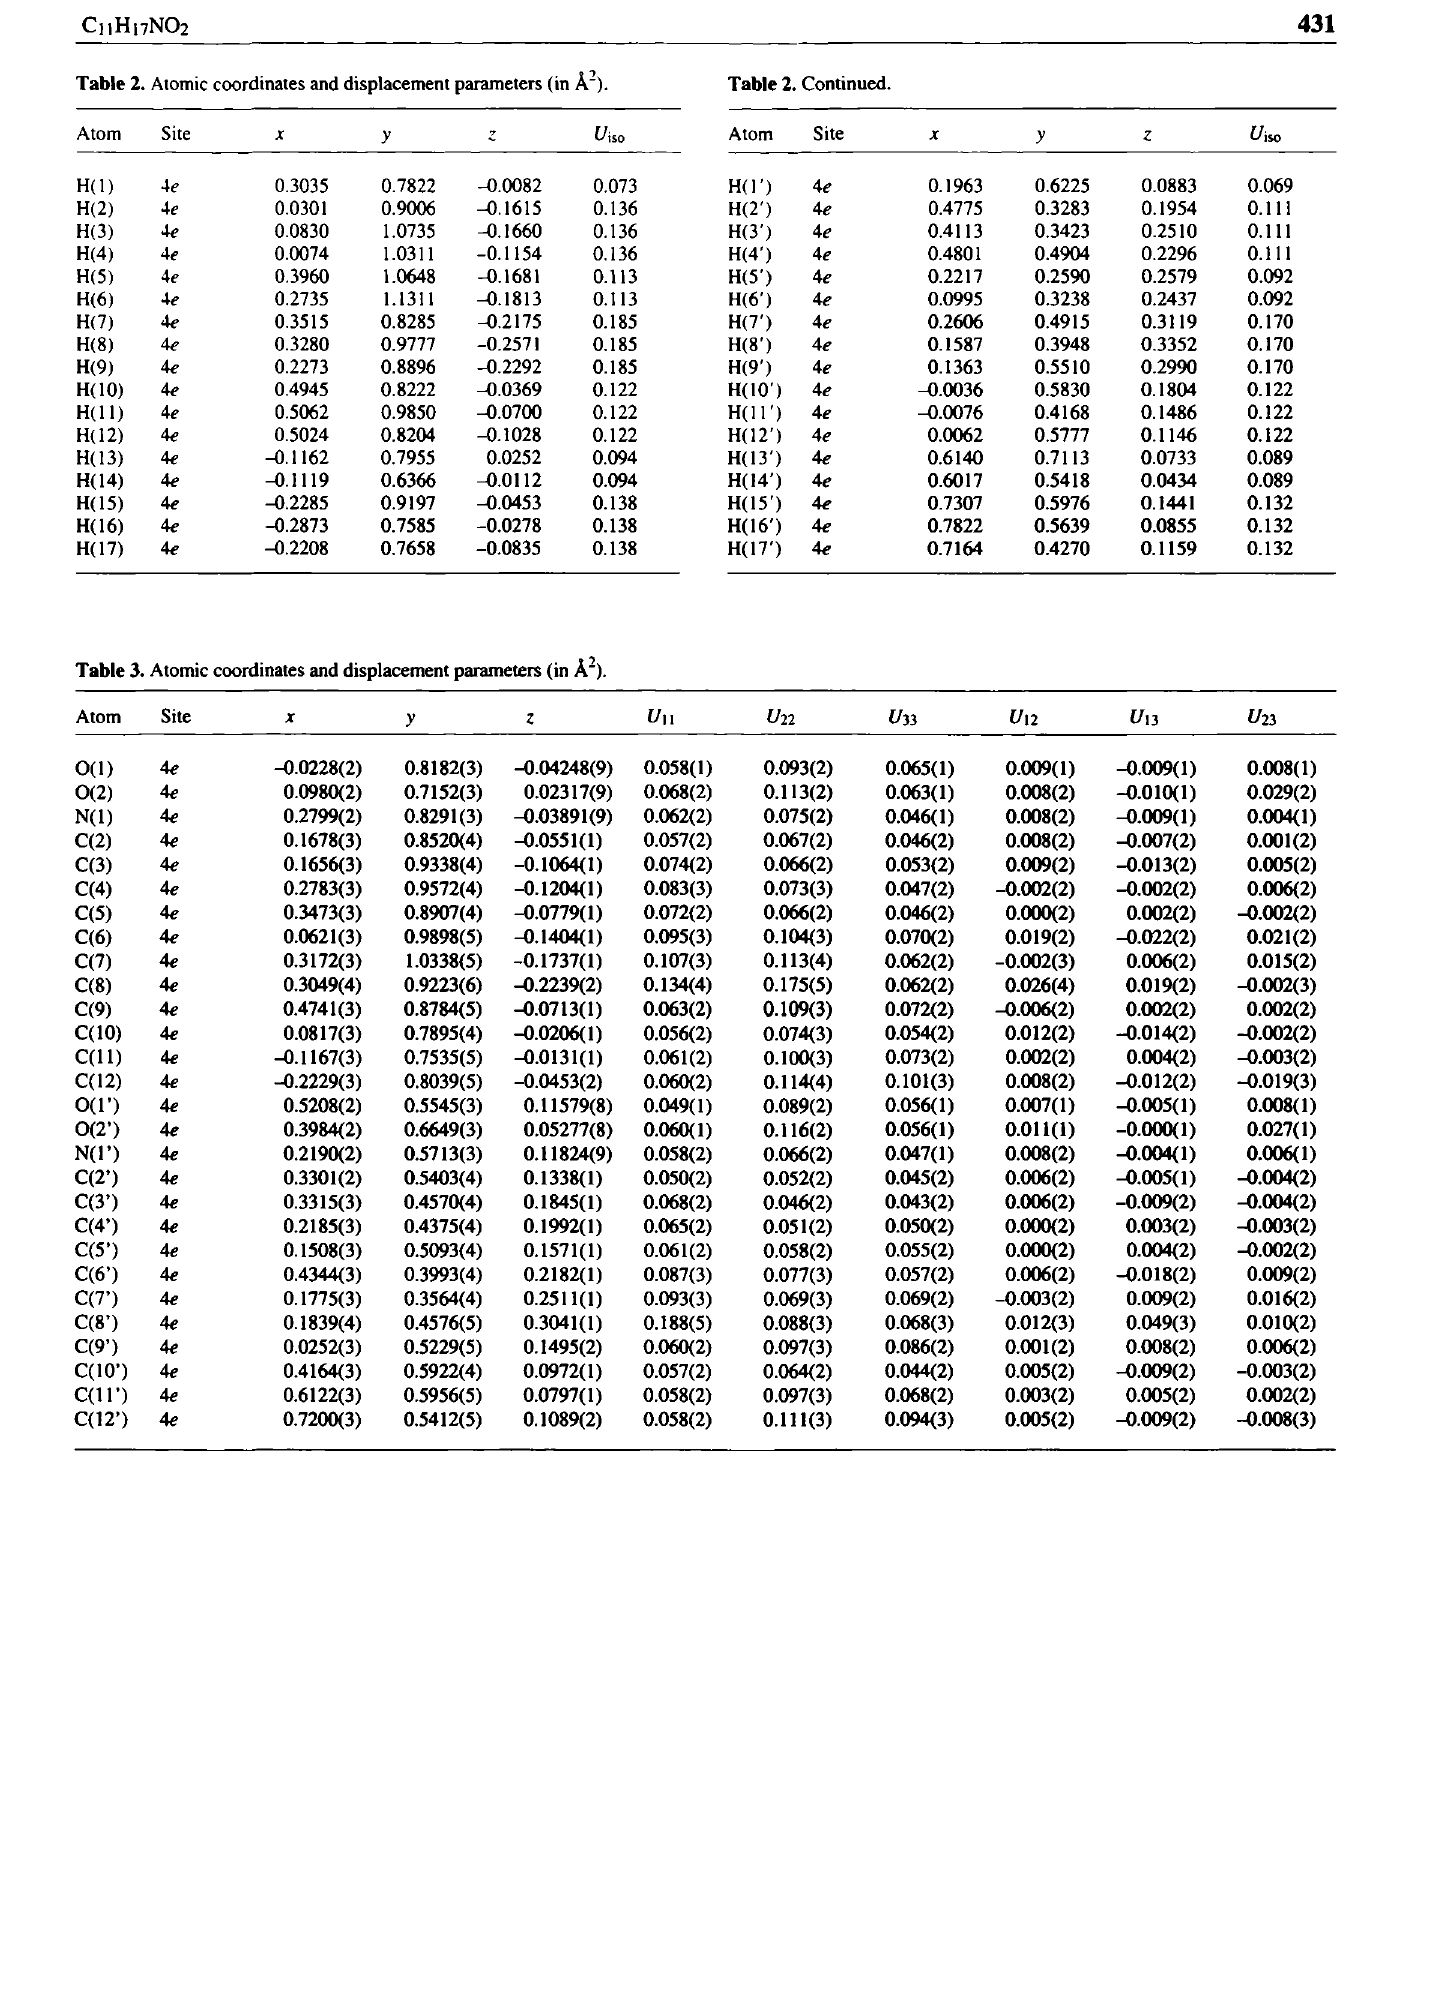
Table 2. Atomic coordinates and displacement parameters (in À 2 ).